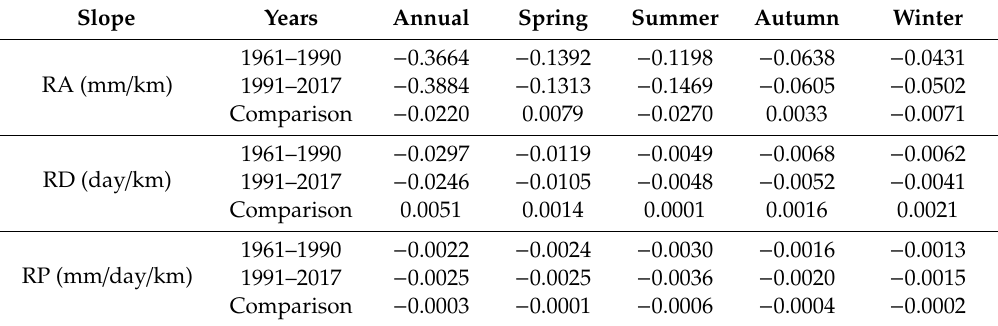
Table3. Simplelinearregressionslopeofrainfallamount(RA),rainfalldays(RD),anddailyprecipitation on rainy days (RP) versus sea distance from 1961–1990 and